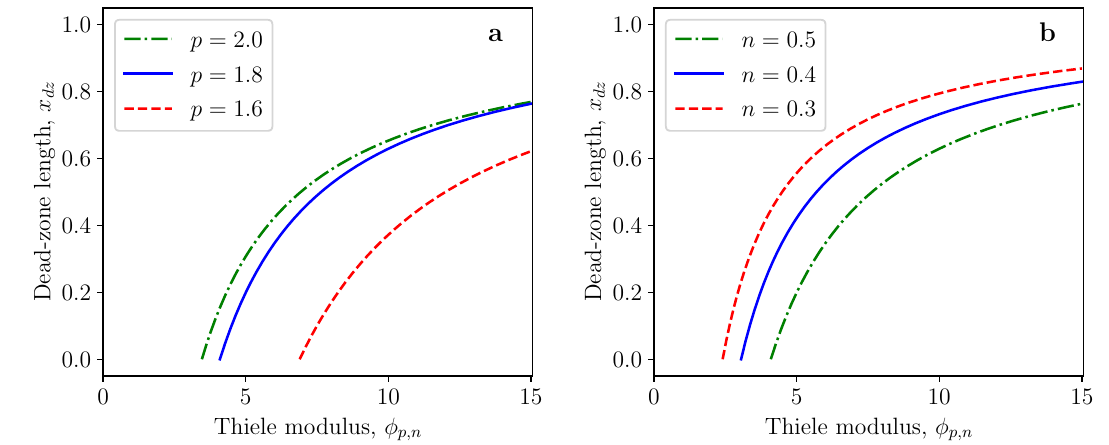
Figure 4. Effect of Thiele modulus on dead-zone length for ( a ) various diffusion exponents and ( b ) reaction orders.